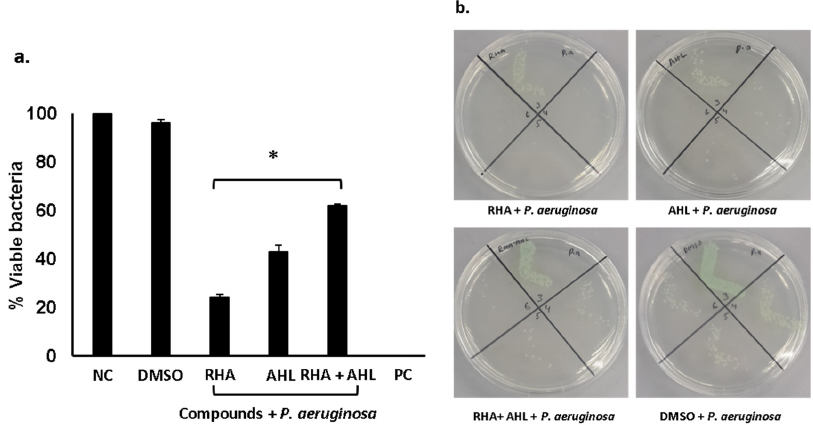
Figure 4. Antibacterial assays of pure compounds against P. aeruginosa. Briefly, pure compounds at 50 µg/mL were incubated with 1 × 10 6 bacteria for 2 h at 37 °C. Next, cultures were diluted and plated onto agar plates. The plates were incubated at 37 °C for overnight. After this incubation, viable bacterial colonies were counted to determine, ( a ) bactericidal and ( b ) bacteriostatic activities of rhamnolipids and N -acyl homoserine lactones against P. aeruginosa. The data are expressed as the mean ± SE of several independent experiments performed in duplicate. P -values were determined by student’s T-test where (*) represents P < 0.05 using GraphPad Prism software 8.0.2.